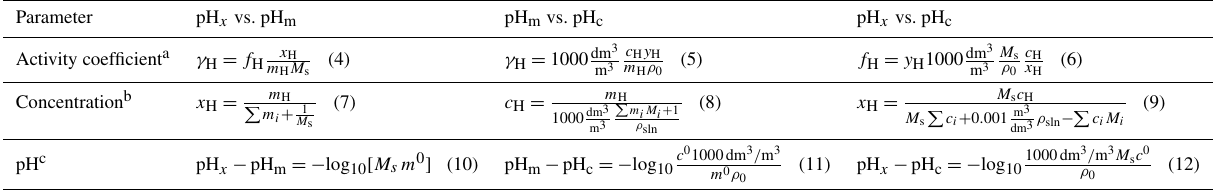
Table 1. Summary of equations for the interconversion of concentration and activity coefficient of H + based on different standard states. Parameter